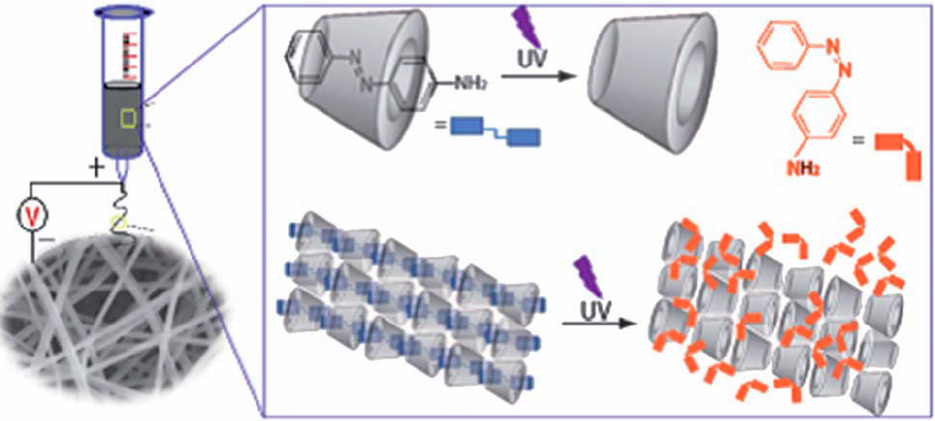
Figure 7. Fibers prepared with HP β CD/4-aminoazobenzene inclusion complexes